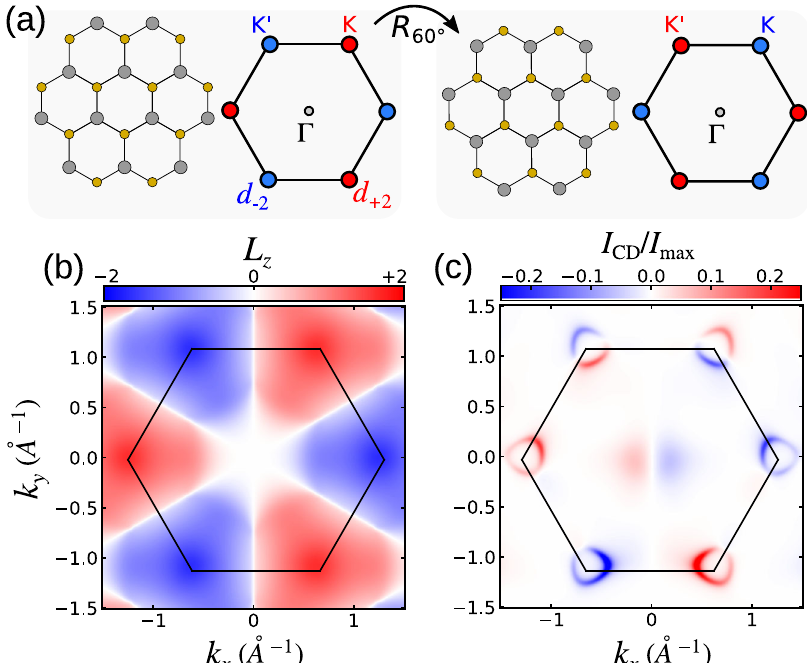
Fig. 2 Orbital angular momentum and circular dichroism. a Top view of the WSe 2 monolayer and sketch of the fi rst Brillouin zone. Upon rotating the crystal by 60°, the dominant orbital character at K (K 0 ) reverse from the magnetic state d + 2 ( d − 2 ) to d − 2 ( d + 2 ), thus emulating the time-reversal operation. b Out-of-plane component of the orbital angular momentum L z of the top valence band. The value of L z is represented by the color as given by the color bar. c Calculated circular dichroism I CD ( k , E ) = I LCP ( k , E ) − I RCP ( k , E ) (LCP/RCP: left/right-hand circularly polarized) at binding energy E − E VBM = − 0.215 eV for the orientation on the left-hand side of ( a ). Positive (negative) values are indicated by red (blue) color as given by the color bar above. The circular dichroism for the rotated crystal orientation is qualitatively similar. The probe pulse is coming from